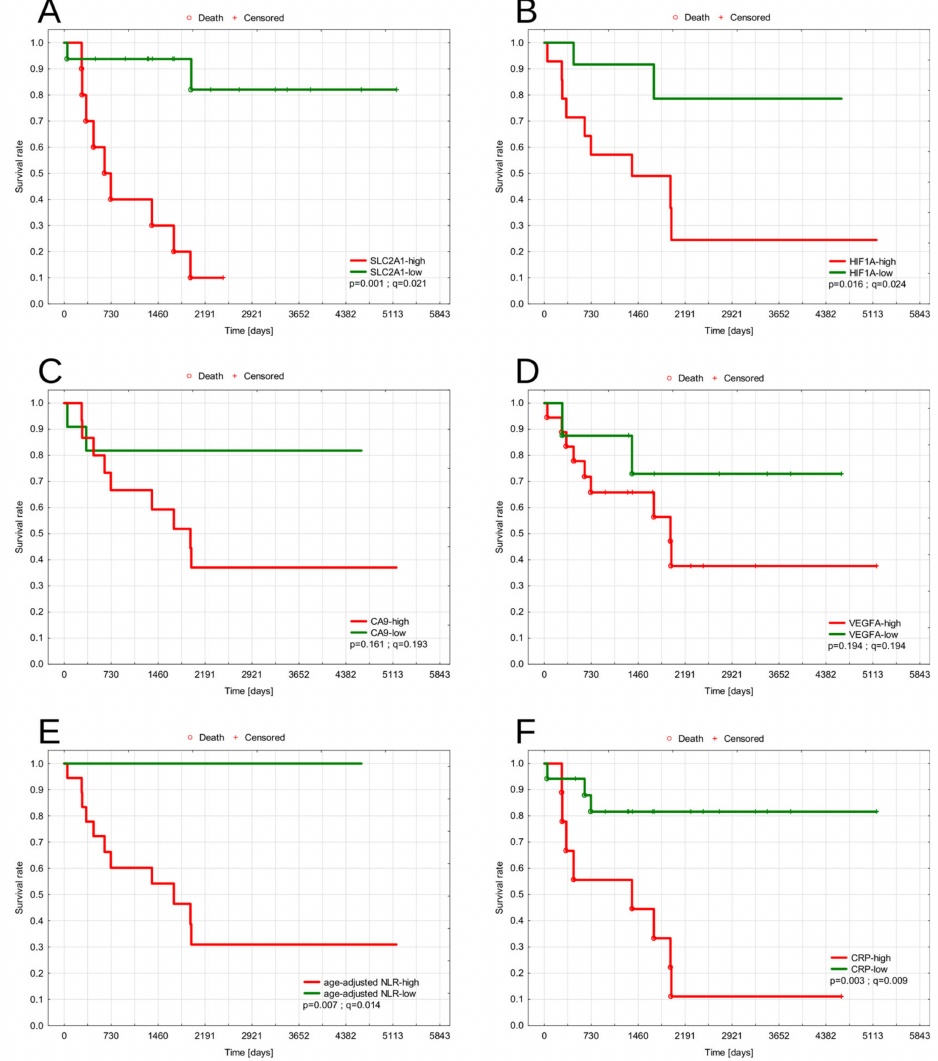
Figure 10. Kaplan–Meier plots showing overall survival stratified by SLC2A1 ( A ), HIF1A ( B ), CA9 ( C ), VEGFA ( D ), NLR ( E ), CRP ( F ). Abbreviations: SLC2A1—solute carrier family 2 member 1, HIF1A—hypoxia-inducible factor-1 α , CA9—carbonic anhydrase 9, VEGFA—vascular endothelial growth factor A, NLR—neutrophil-to-lymphocyte ratio, CRP—C-reactive